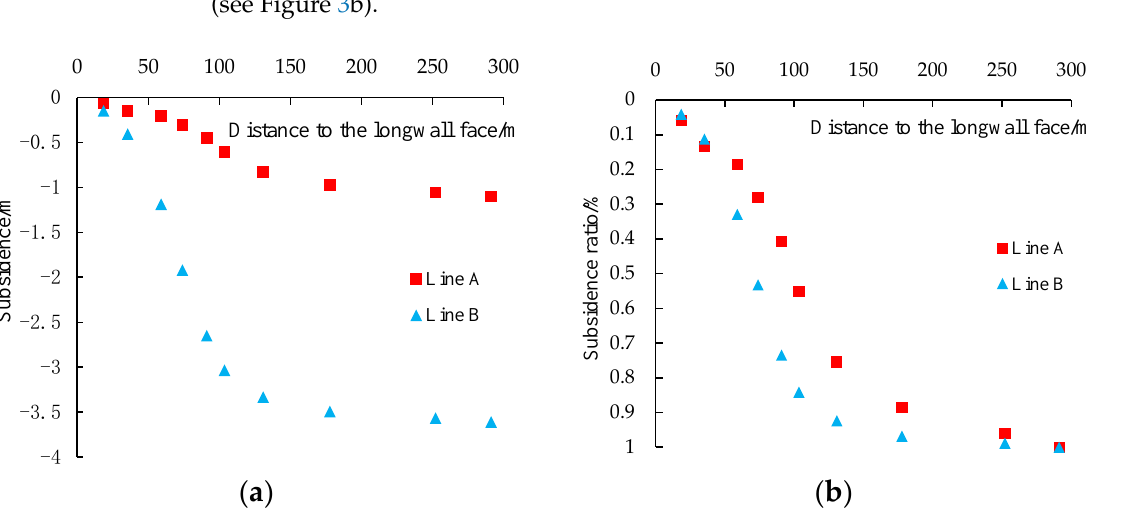
Table 1. Surface deformation parameters at the left and right sides of the working face.